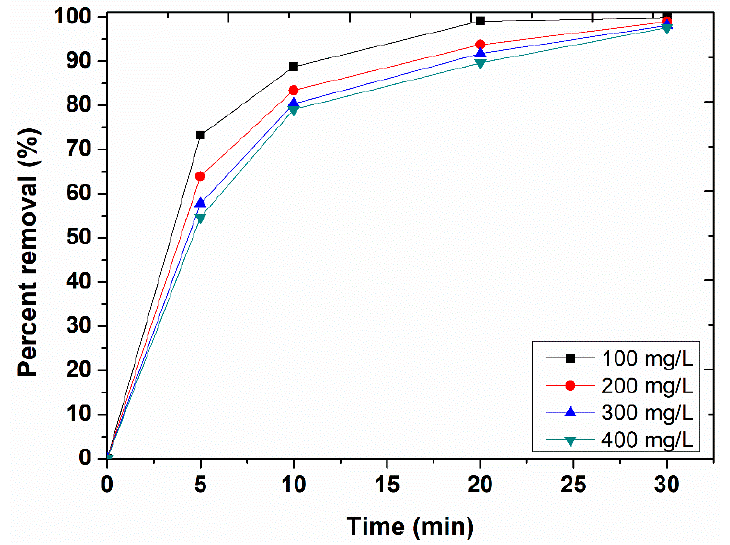
Figure 3. Effect of initial concentrations of imidacloprid on its degradation percentage by using combined photocatalytic ozonation process.